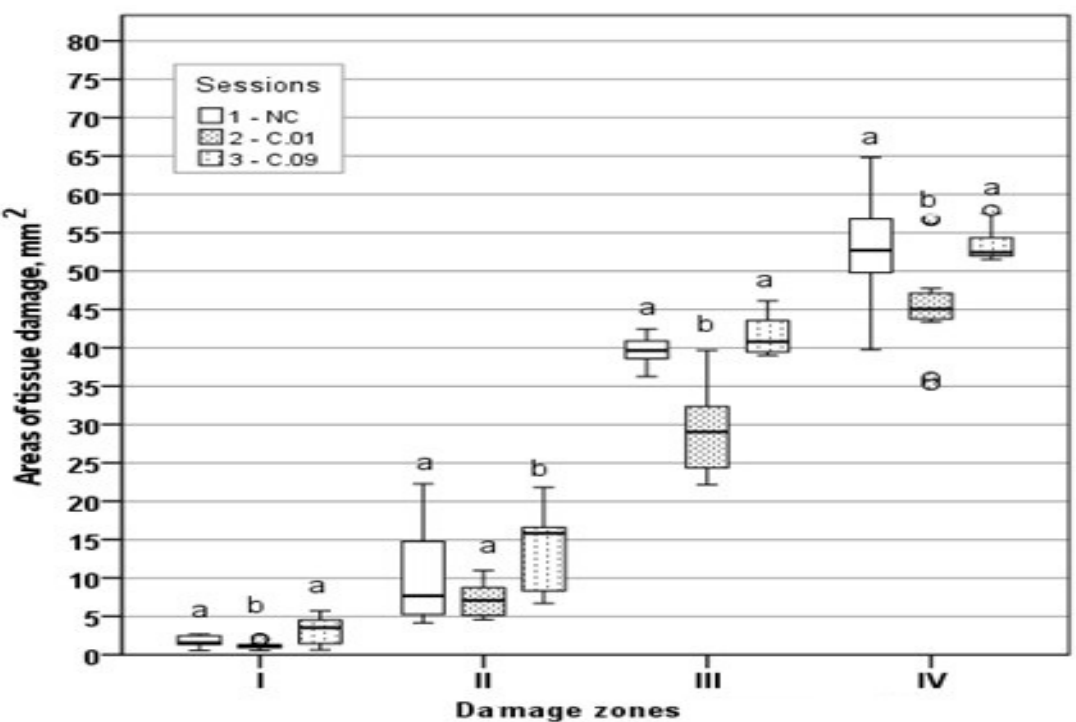
Figure 6. Graphical comparison of tissue damage area distributions by zones. a, b—the distributions differed statistically significantly as found by a non-parametric Kruskal–Wallis test.